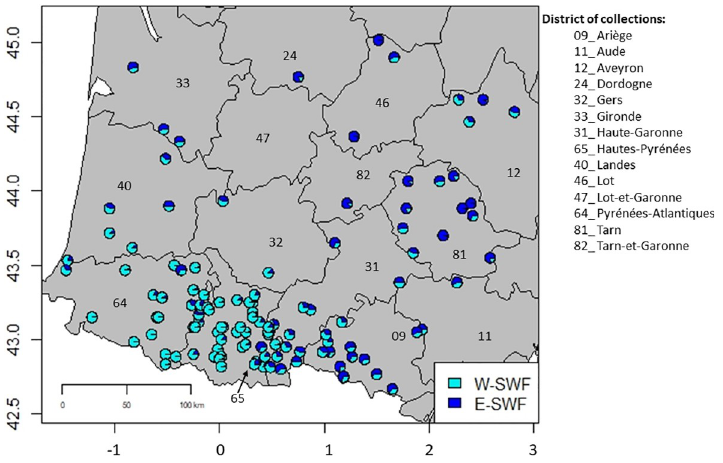
Fig 2. Geographical representation of the 158 maize landraces from the South-West of France (36 landraces having no geographical coordinates were not plotted). The districts of collection sites are represented with administrative numbers. Landraces for which pie-diagrams had both blue and cyan colors exhibited mixed genetic origins between E-SWF and W-SWF groups. The map was created using R software (libraries maps, plotrix, mapproj,